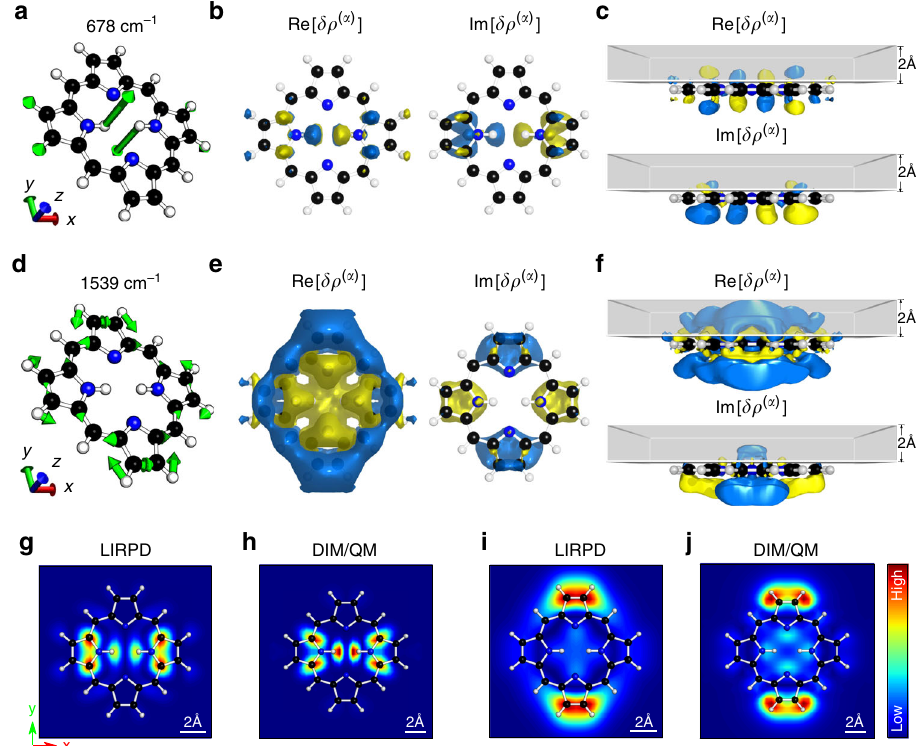
Fig. 3 Normal modes, Raman polarizability densities, and TERS images of porphyrin. a – c Normal modes at 678 cm − 1 and d – f at 1539 cm − 1 . a , d Schematic representation of molecular vibrations. b , e The Raman polarizability densities in real (left) and imaginary (right) parts of porphyrin on a Au(111) surface from the top view. c , f The Raman polarizability densities are distributed throughout the scanning volume with the thickness of 2 Å above porphyrin plane from the side view. The densities are normalized and the absolute isovalue is set to 0.2 with the positive sign in blue and the negative sign in yellow. Simulated TERS images of modes at 678 cm − 1 ( g , h ) and 1539 cm − 1 ( i , j ) obtained by LIRPD ( g , i ) and DIM/QM approaches ( h , j ),